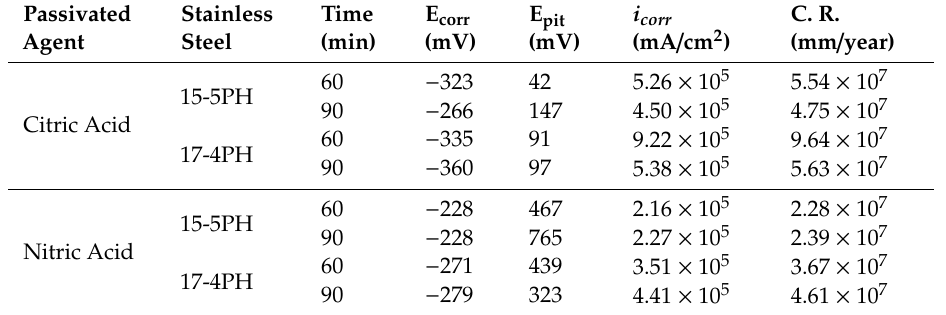
Table 4. Potentiodynamic polarization parameters in stainless steels passivated at 49 ◦ C, in 5 wt. % NaCl.